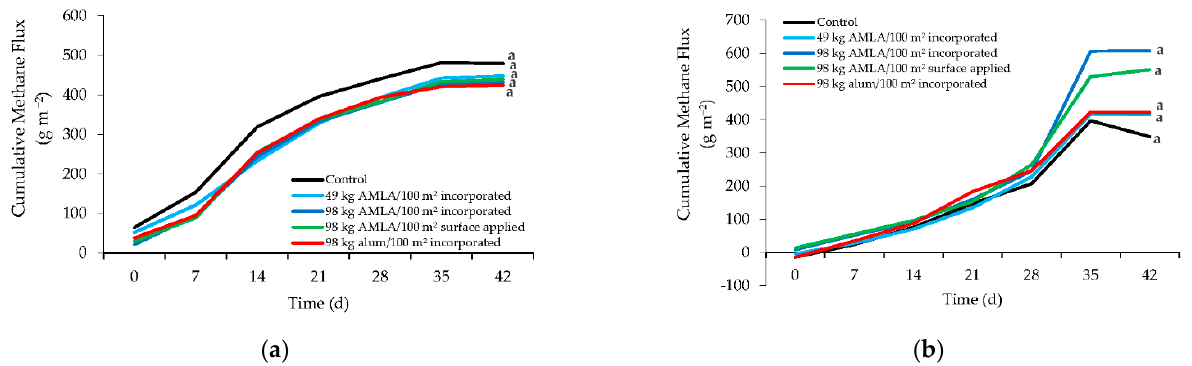
Figure 3. Cumulative methane flux (g CH 4 m − 2 ) for ( a ) flock 2 and ( b ) flock 3 as a function of time. Treatments on day 42 not sharing a common letter are significantly different ( p < 0.05). Table 3. Average methane flux (mg CH 4 m − 2 hr − 1 ) for flock 2 and 3 by treatment and sampling date. Table 4. Average carbon dioxide flux (g CO 2 m − 2 hr − 1 ) for flock 2 and 3 by treatment and sampling date. Day Treatment Avg.